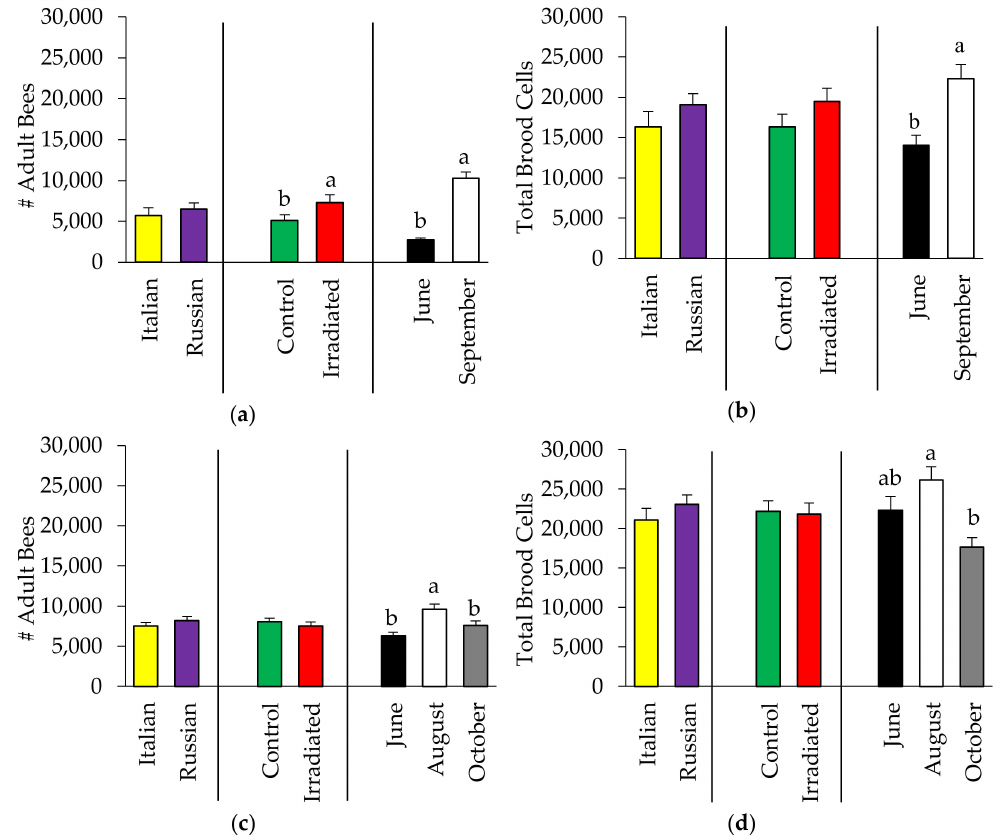
Figure 1. Bee and brood production (mean ± SE) in Italian and Russian honey bee colonies having irradiated or non-irradiated (control) combs: ( a ) 2015 adult bees; ( b ) 2015 brood cells; ( c ) 2016 adult bees; and ( d ) 2016 brood cells. For each group, bars with the same letters are not significantly different ( p > 0.05); without letters indicates no